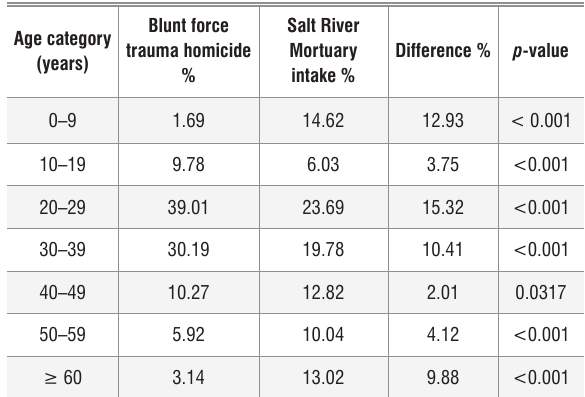
Comparison of the age distribution between blunt